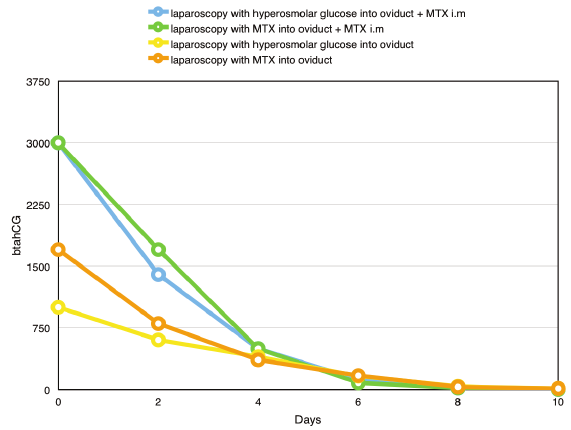
Figure 1: Decrease beta-HCG value, depending on the type of ope